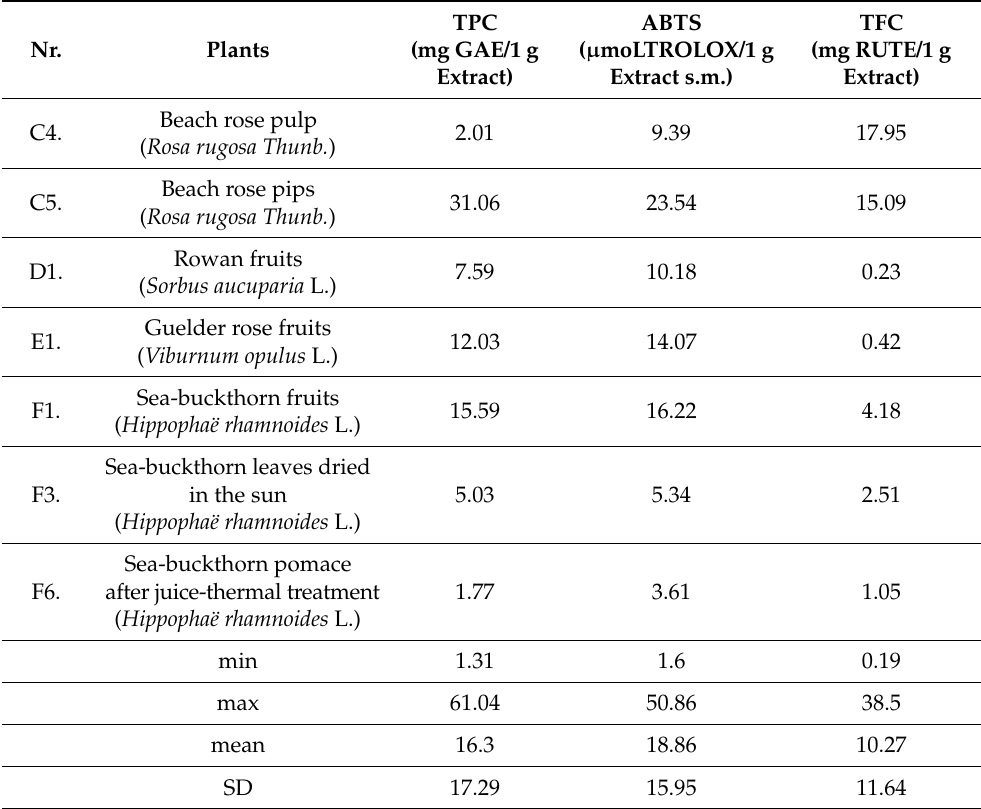
Table 1. The total phenolic content (TPC (mg GAE/1 g extract)), total flavonoid content (TFC (mg RUTE/1 g extract)), and ABTS + ((2,2′-azino-bis(3-ethylbenzothiazoline-6-sulfonic acid (µmolTROLOX/1 g extract s.m.)) in the plants tested.